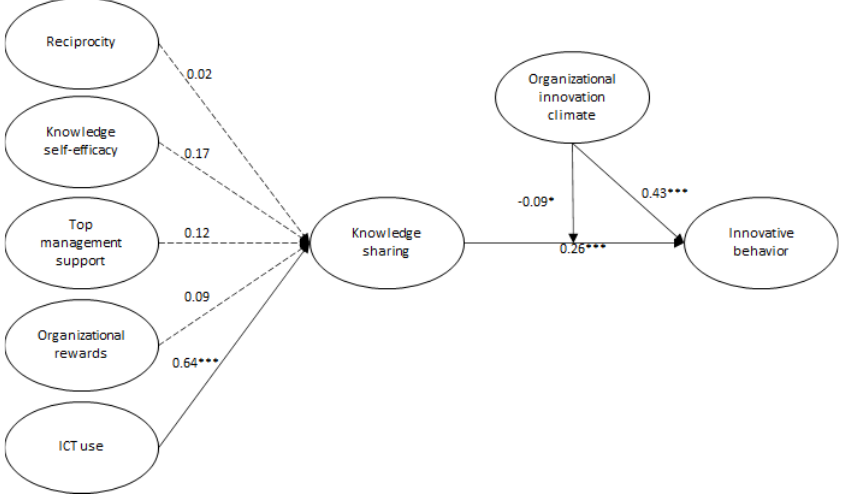
Figure 2. Results of the proposed model. Note(S): Dashed lines indicate insignificant paths: *** p < 0.001; * p < 0.05. The model’s effect size (f 2 ) measures the accuracy with which the exogenous variables predict the endogenous variables. According to Aguinis et al. [81], the effect size ranges between 0.02, 0.15, and 0.35. Where f 2 = 0.02 denotes a minor effect, f 2 = 0.15 is a medium effect, and f 2 = 0.35 is a significant effect. Table 4 shows that OIC has the most substantial effect on IB (f 2 = 0.150), followed by the KS effect on IB (f 2 = 0.055), which has the slightest effect. Similarly, the effect size of the interaction term, i.e., OIC (f 2 =0.018) is limited. Aguinis et al. [81] suggested that moderators with even lower effects cannot be ignored. Therefore, the study’s H4 is also accepted. 6. Discussion This study joins recent efforts that call attention to the theoretical and methodological distinctions between formative and reflective measurement models to address the lack of formative measurement models in KS research [69]. One of the goals of this study was to determine, from the viewpoint of graduate students enrolled in master’s degree programs in engineering and construction management in Spain, which facilitators had the most significant influence on the capabilities to exchange knowledge. A second objective was empirically determining whether KS positively impacted innovation behavior from the respondents’ perspective. Finally, it was necessary to demonstrate whether the relationship between KS and innovation behavior was supported by environments that promote innovation. Structural equation model analysis of the first set of hypotheses confirmed that, among the group of knowledge facilitators, only ICT use had a statistically significant effect on KS. Table 4 presents results indicating that respondents believe KS is most affected by ICT use. The remaining predictors of KS were not statistically significant for the respondents. This research complements previous research by hypothesizing that the future construction workforce relies on the use of ICT to consolidate their ability to share knowledge, which is very different from what the literature shows at the organizational level, as noted below. The results revealed that reciprocity had no significant effect on KS. Therefore, they are not consistent with the arguments of Caimo and Lomi [12], Richards [13], and Tamjidyamcholo et al. [14]. We suggest that to ensure a sense of reciprocity, it is necessary